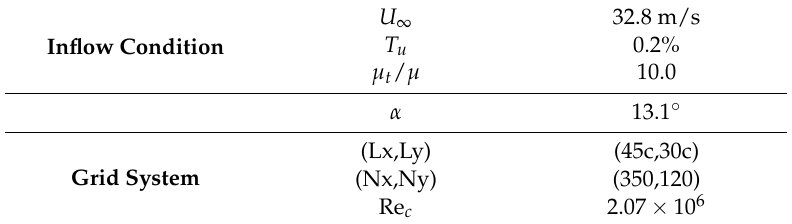
Table 6. Information about the inflow conditions and grid system for flow over Aerospatiale A-airfoil.